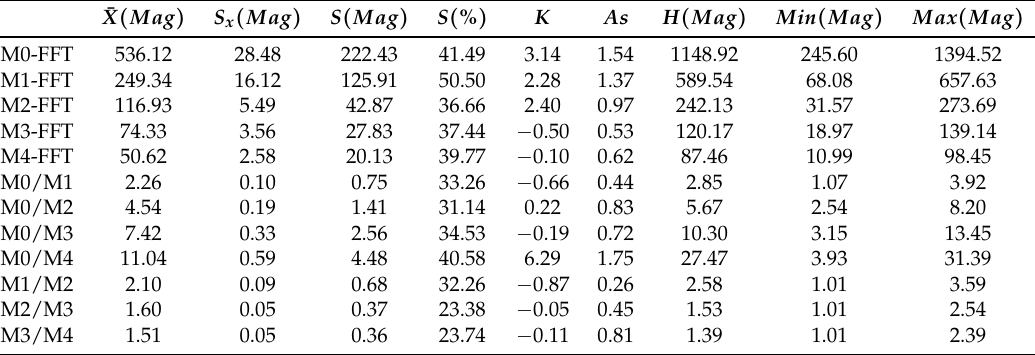
Table A4. Statistical descriptive measures of the data without outliers by magnitude measurement of the standard group of A. fraterculus